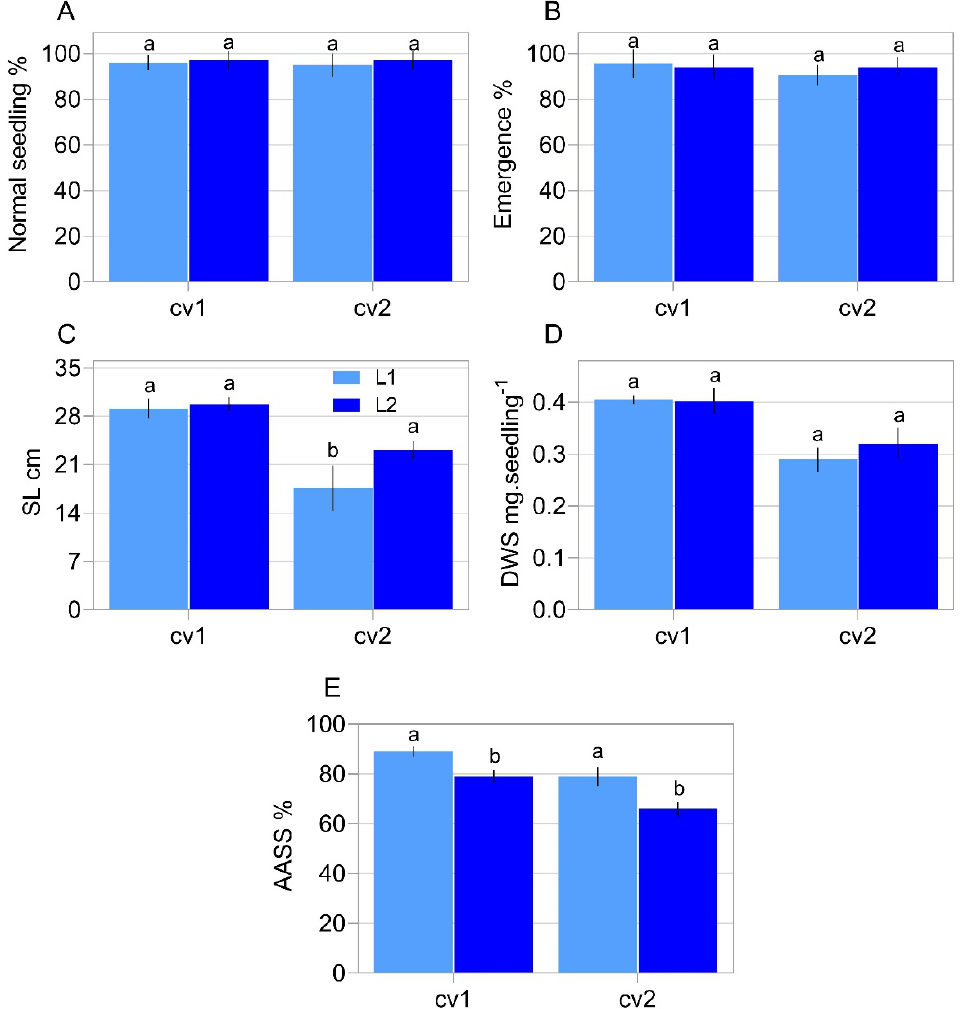
Figure 1. Physiological properties in two commercial cultivars (cv1-BRS133 and cv2-MG/BR 46 (Conquista)) and their respective seed lots (L1: lot 1 and L2: lot 2). Normal seedlings ( A ), seedling emergence ( B ), seedling length ( C ), seedling dry weight ( D ) and accelerated ageing using saline solution–AASS ( E ). Different letters indicate a significant difference at the 5% probability level ( p < 0.05). Error bars show standard deviation ( n = 8).